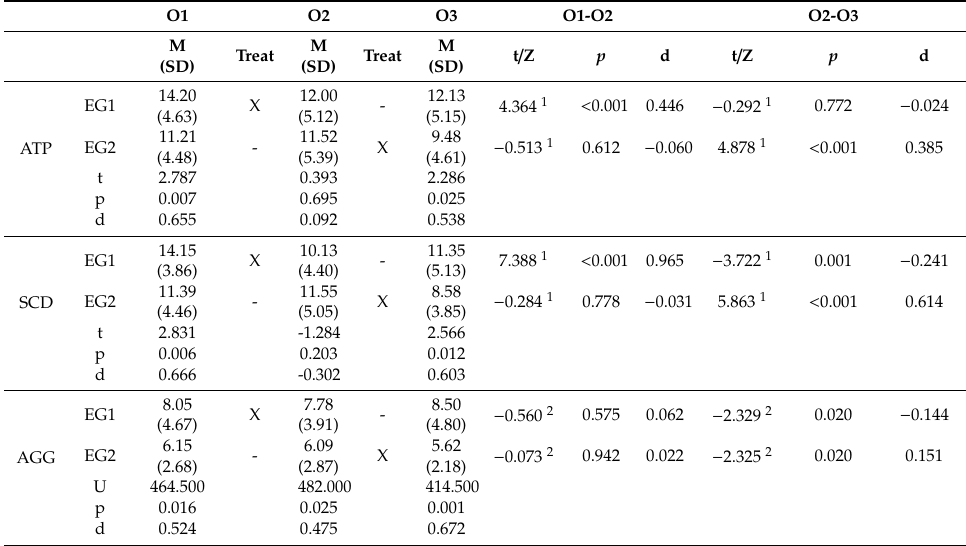
Table 6. A cross-sectional and longitudinal comparison of the levels of pupils’ attention problems, self-control deficits, and aggressiveness, as reported by their teachers (n GE1 = 40; n GE2 = 33).